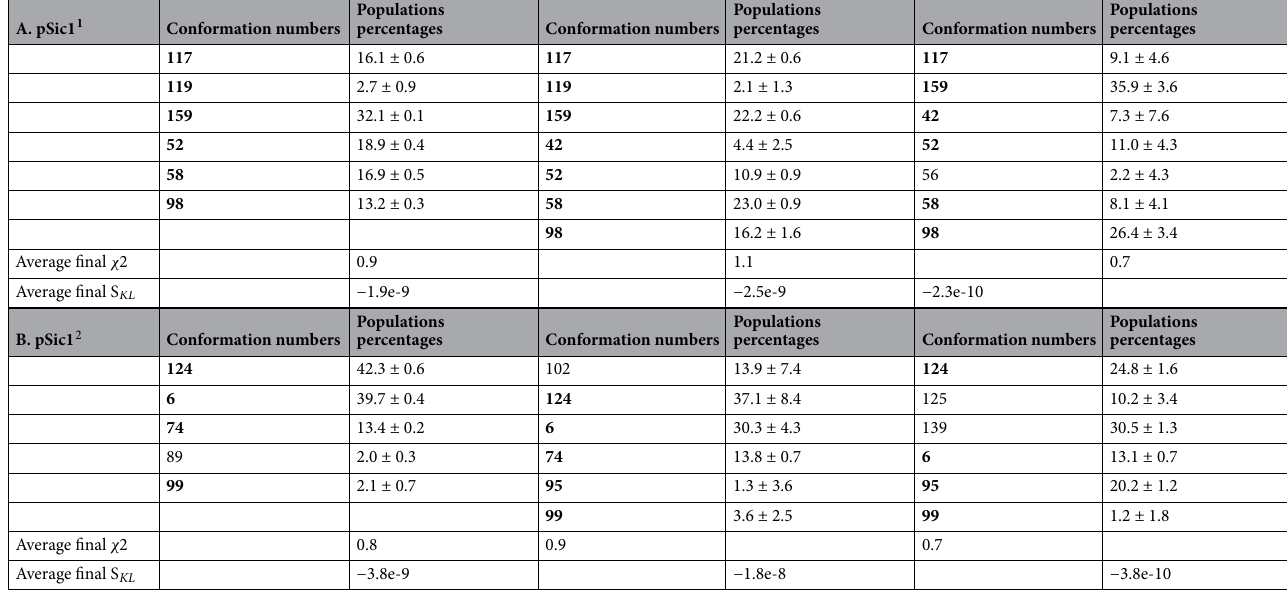
Table 2. Conformations and populations selected using BioEn 0.1.1 18 on the three sets of SAXS curves. The conformations were generated by the runs pSic1